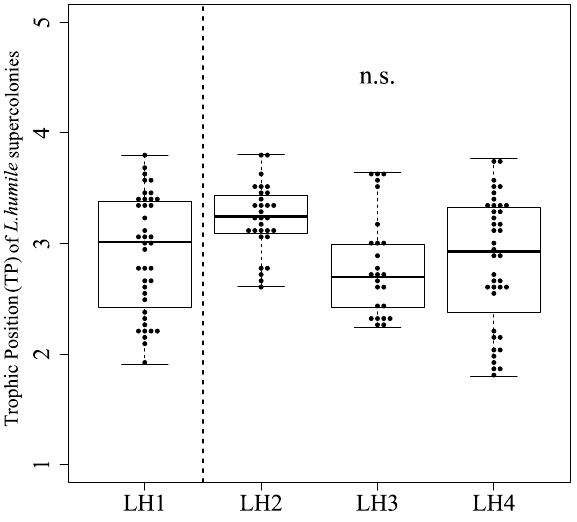
Figure 3. Differences in the trophic position (TP) of L. humile between the LH1 supercolony (main supercolony) and the other supercolonies (LH2, LH3, LH4) in Kobe, Hyogo, Japan, determined using Mann– Whitney U